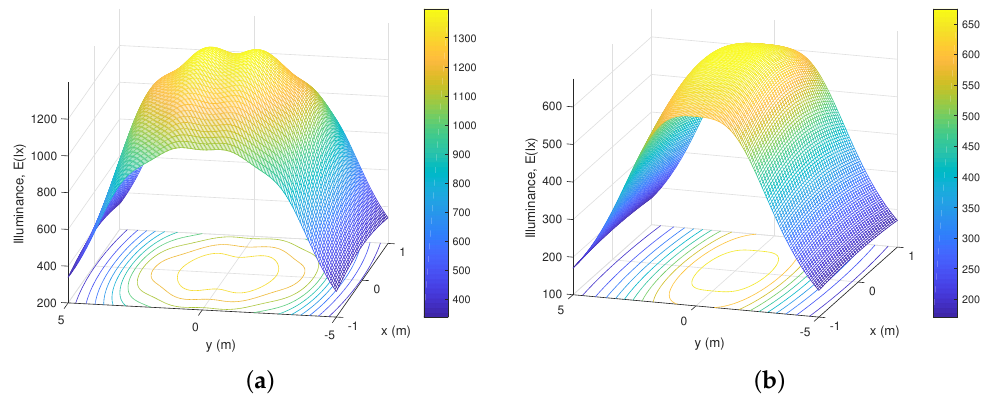
Figure 7. Illuminance distribution of underground mining VLC scenarios for the ( a ) mining roadway and ( b ) mine working